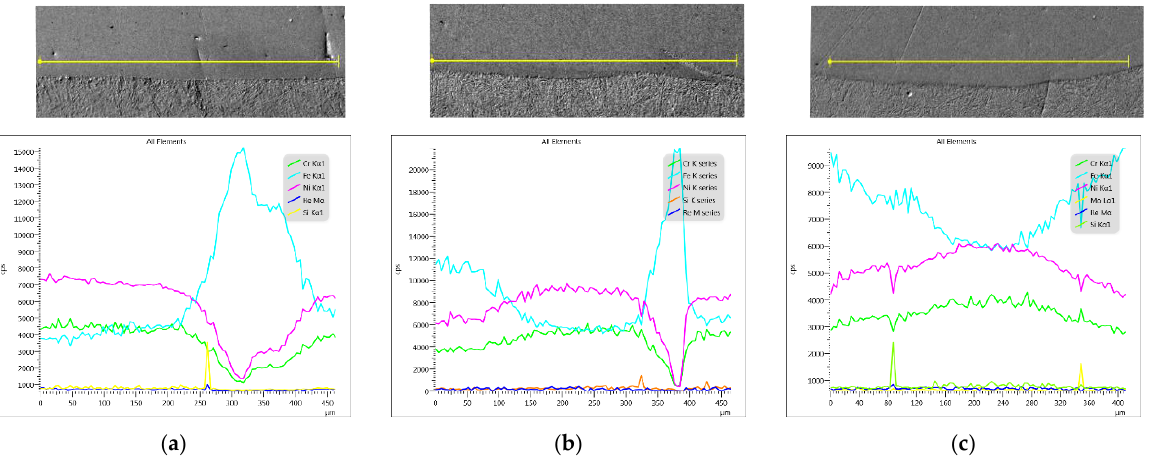
Figure 11. Linear element distributions in the cross-section parallel to the fusion line for laser power of ( a ) 2100, ( b ) 2400, ( c ) 2700 W.